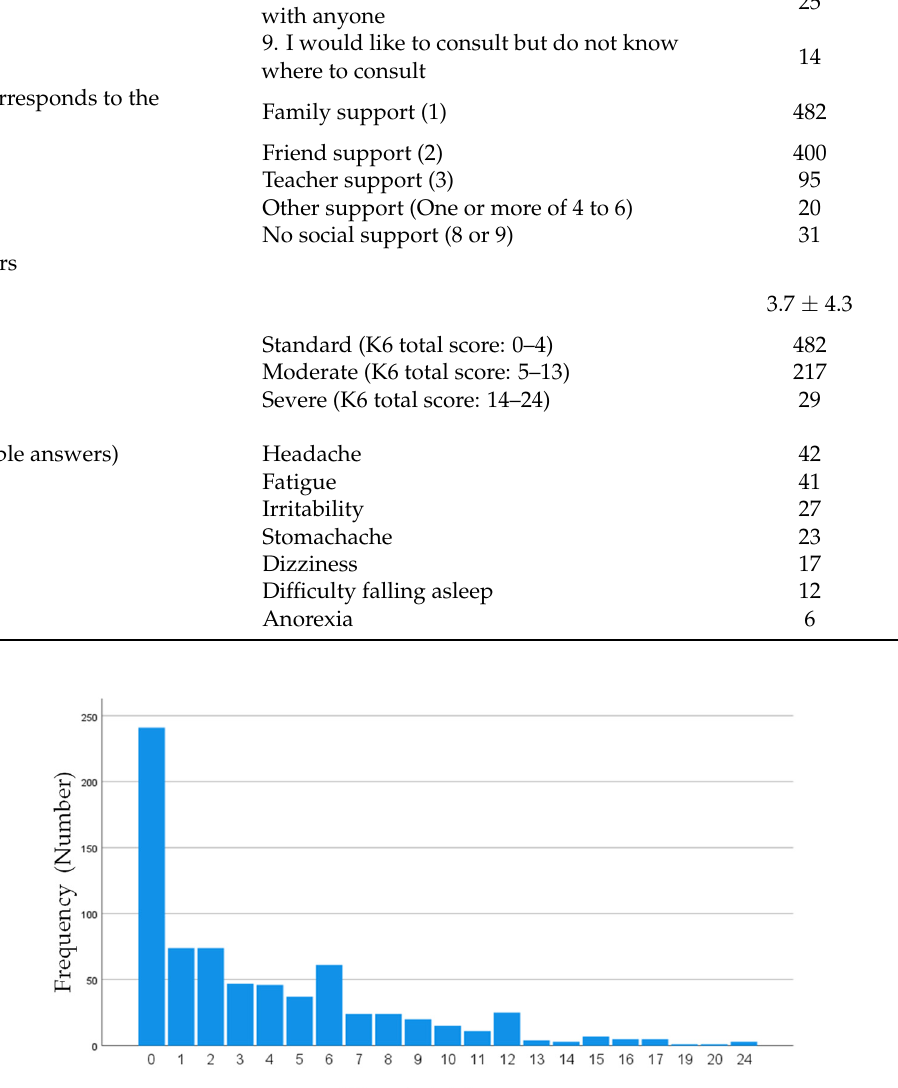
Table 3. Correlation coefficients of the study variables.